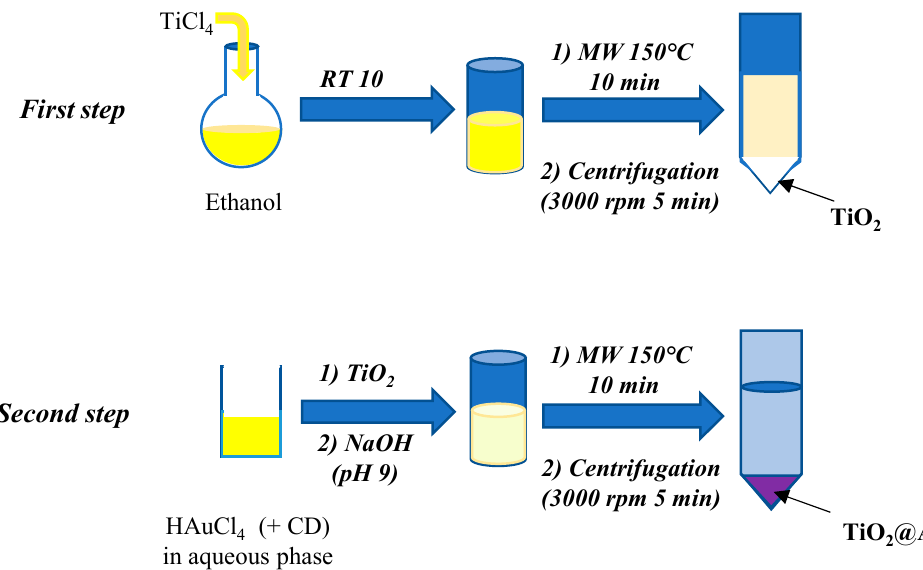
Figure 1. Schematic illustration of the two-step microwave (MW) procedure used for the TiO 2 @Au materials synthesis.